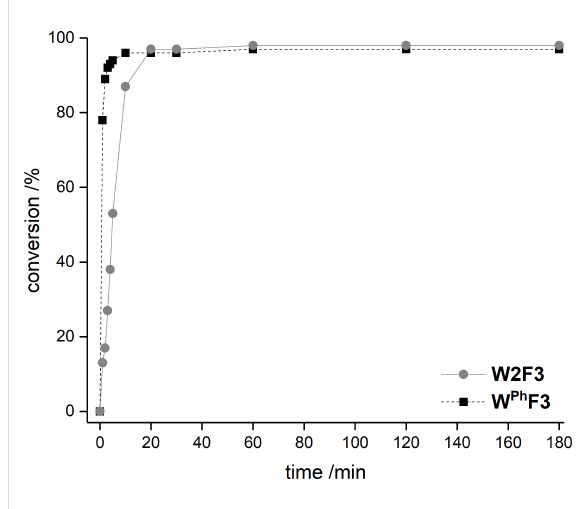
Figure 4: Conversion versus time diagram for the self-metathesis of 1-phenyl-1-propyne catalyzed by 0.5 mol % W2F3 (grey) and 1 mol % W Ph F3